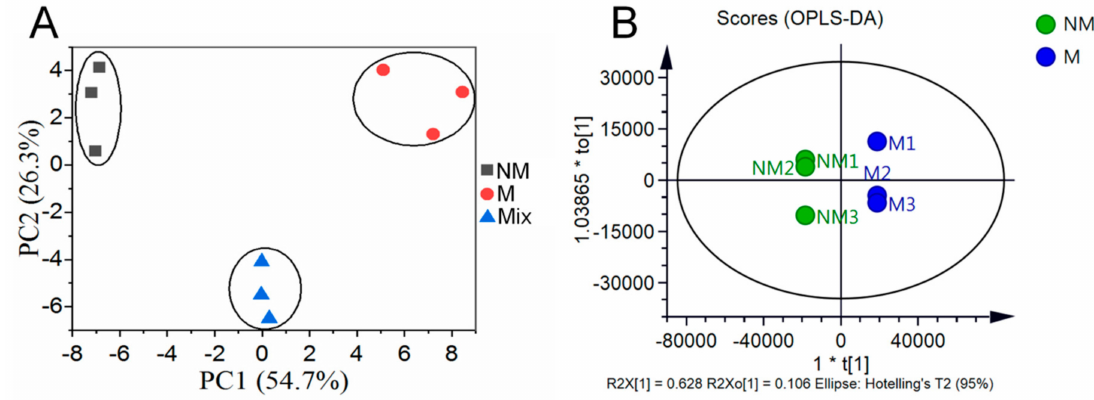
Figure 2. PCA and OPLS-DA scores plots derived from ultra-performance liquid chromatography-electrospray ionization-tandem mass spectrometry (UPLC-ESI-MS / MS) profiling of non-mycorrhizal A. roxburghii (NM) and mycorrhizal A. roxburghii (M) growth for six months. ( A ) PCA scores plot of the two samples (NM and M growth for six months) and the quality control sample (mix, the same volume of sample extract from the NM and M growth for six months was prepared by mixing); the x-axis represents the PC1 and the y-axis represents PC2. ( B ) OPLS-DA scores plot of the putatively annotated metabolites from NM and M growth for six months. The x-axis represents the score value of main components in the orthogonal signal correction process and the di ff erences between the groups can be seen from the direction of the x-axis; the y-axis represents the scores of orthogonal components in the orthogonal signal correction process and the di ff erences within the groups can be seen from the direction of the